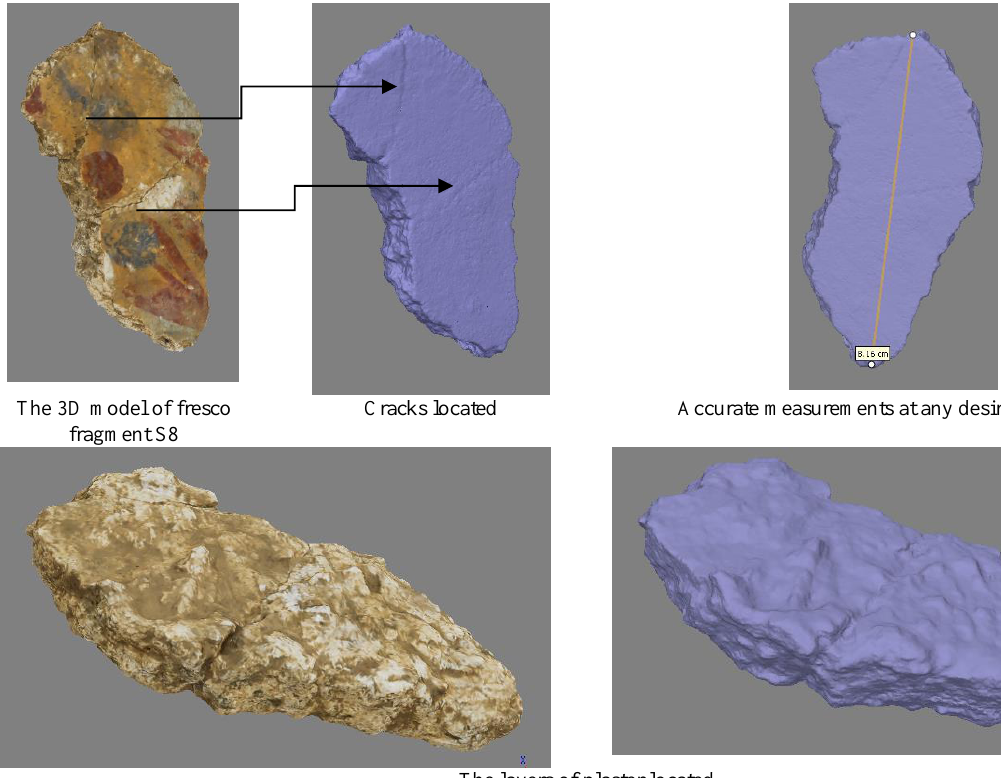
Figure 12. Cases which conservator studies in 3D